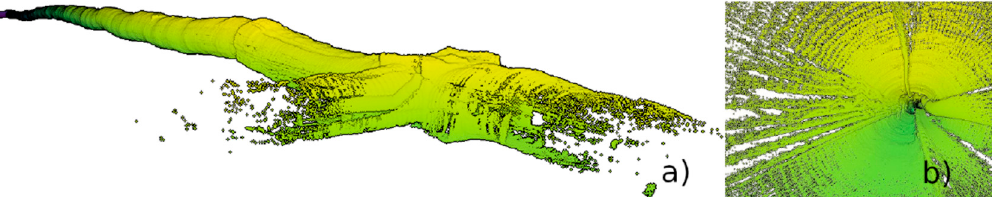
Figure 7. Point cloud of a mine segment. ( a ) Whole cloud (outside view), ( b ) view from inside, along the tunnel (Reprinted from Ref. [50]).